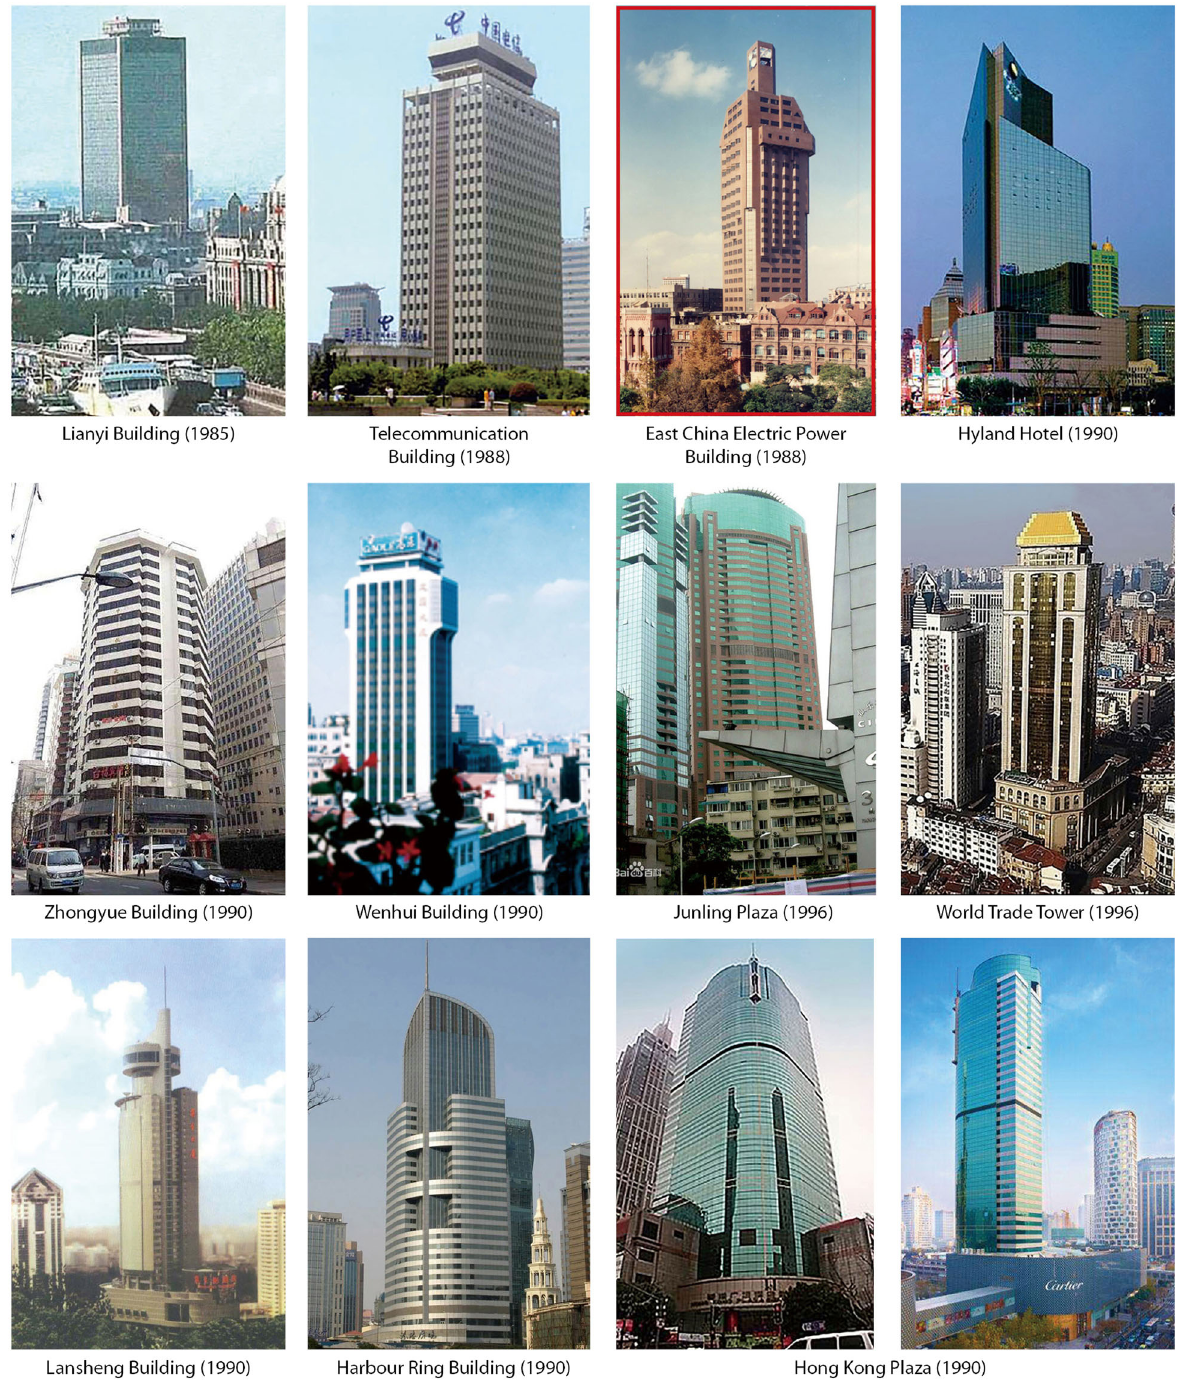
Fig. 2 High-rise buildings in the Bund section of Nanjing Road built from 1980 to 1999 (Source: Photographs from the